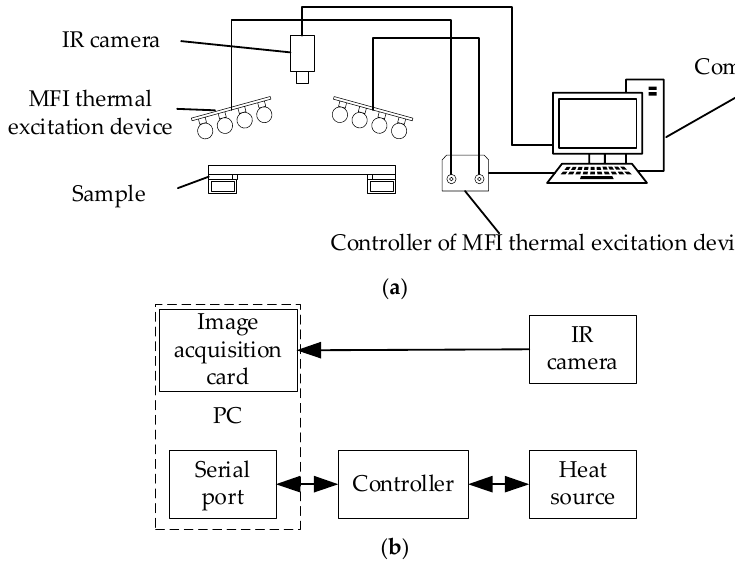
Figure 3. Schematic diagram of active thermal sensing platform for bonded structure damage detection. ( a ) Active thermal sensing platform for bonded structure damage detection; ( b ) framework of active thermal sensing platform for bonded structure damage detection. MFI, mid and far infrared. IR, infrared.